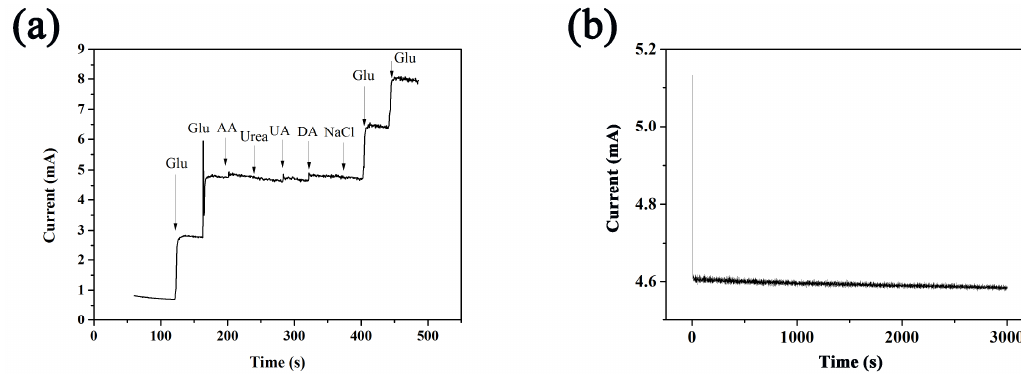
Figure 8. ( a ) Interference test of CuCo 2 O 4 upon addition of successive addition of 50 μM glucose, 5 μM AA, 5 μM urea, 5 μM UA, 5 μM DA, 5 μM NaCl, and 5 μM glucose at the potential of 0.55 V in 0.1 M NaOH solution; ( b ) Time-current curves of CuCo 2 O 4 at the potential of 0.55 V in 0.1 M NaOH solution.